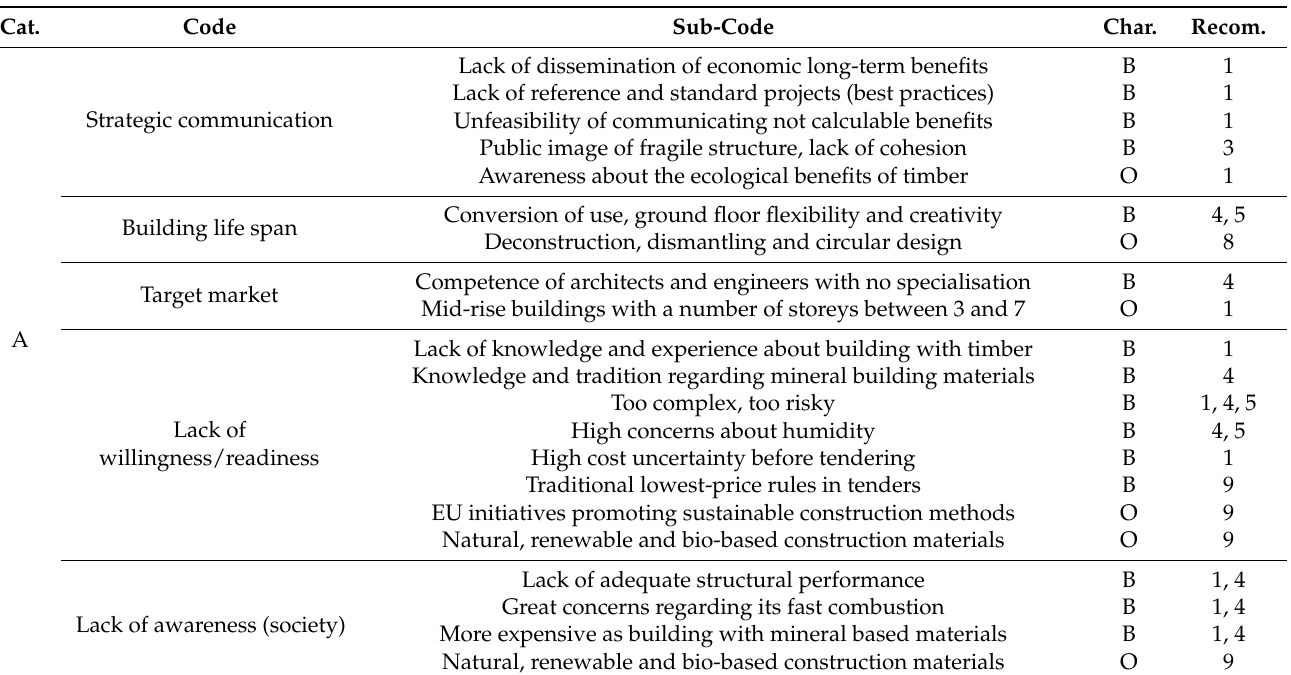
Table A1. Catalogue of all sub-codes according to their code, category (A—Acquisition, D—Design, and P—Production and Assembly) and character (B—Barriers and O—Opportunities) with their proposed recommendation